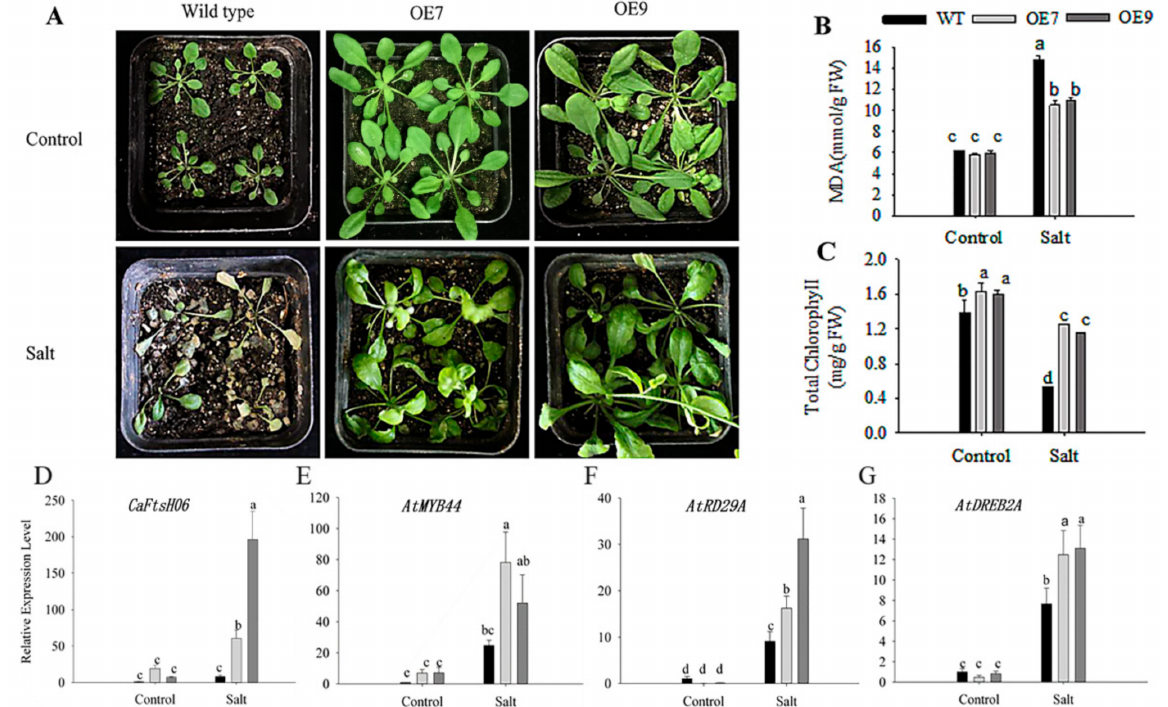
Figure 11. Phenotypic observations and physiological and transcriptional analysis after salt stress in the WT and CaFtsH06 -expressing Arabidopsis plants watered with a 200 mM NaCl solution for 14 days. ( A ) Phenotypes of CaFtsH06 - OE Arabidopsis and WT plants. ( B , C ) MDA and chlorophyll contents of the WT and transgenic Arabidopsis plants. ( D – G ) Expression levels of CaFtsH06 and other stress-related genes in transgenic Arabidopsis and WT plants under salt stress. Different letters denote statistical significance ( p <